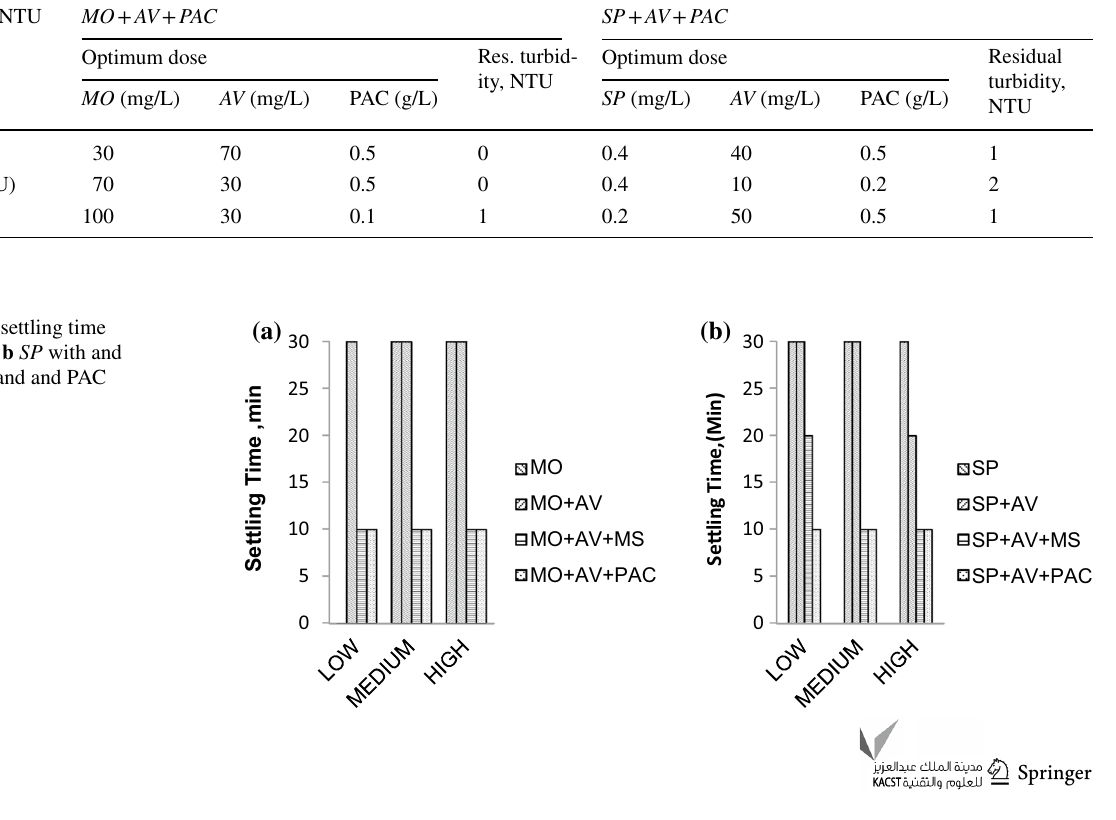
Table 3 Turbidity removal by MO , AV and PAC; and SP , AV and PAC Initial turbidity, NTU